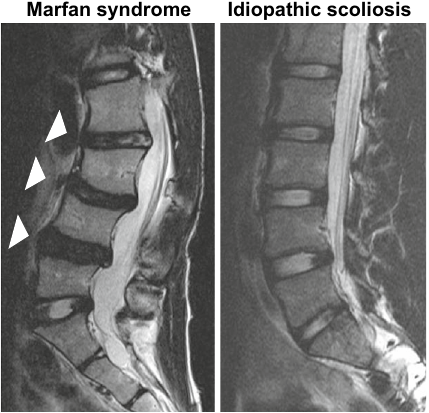
Figure 5. Representative preoperative magnetic resonance imaging (MRI) of the lumbar spine in patients with Marfan syndrome and idiopathic scoliosis. Representative preoperative MRI of the lumbar spine in patients with Marfan syndrome (left) and idiopathic scoliosis (right). Both cases were 14-year-old boys. White arrowheads indicate the degenerated intervertebral